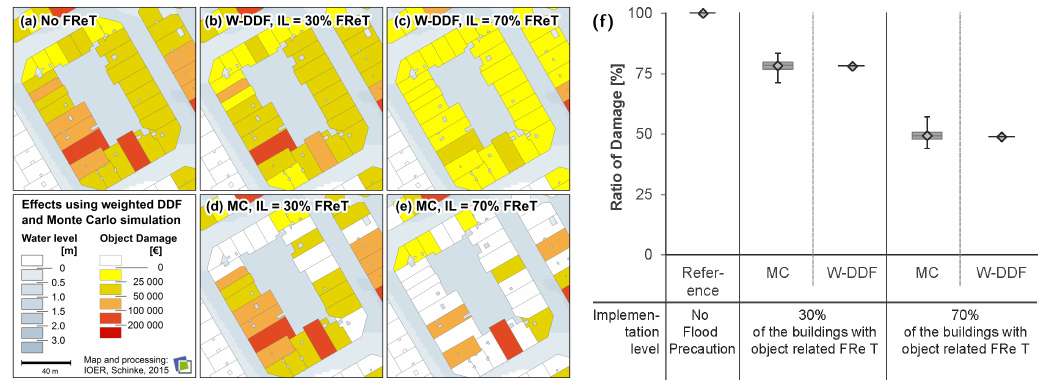
Figure 8. Comparison of the variant analysis using weighted depth-damage function (W-DDF) and Monte Carlo Simulation (MC). Left side: map with one quarter of exposure class II ( a ): reference situation; ( b ), ( c ): W-DDF; ( d ), ( e ): example of one model run (MC); Right side: ( f ) ratio of